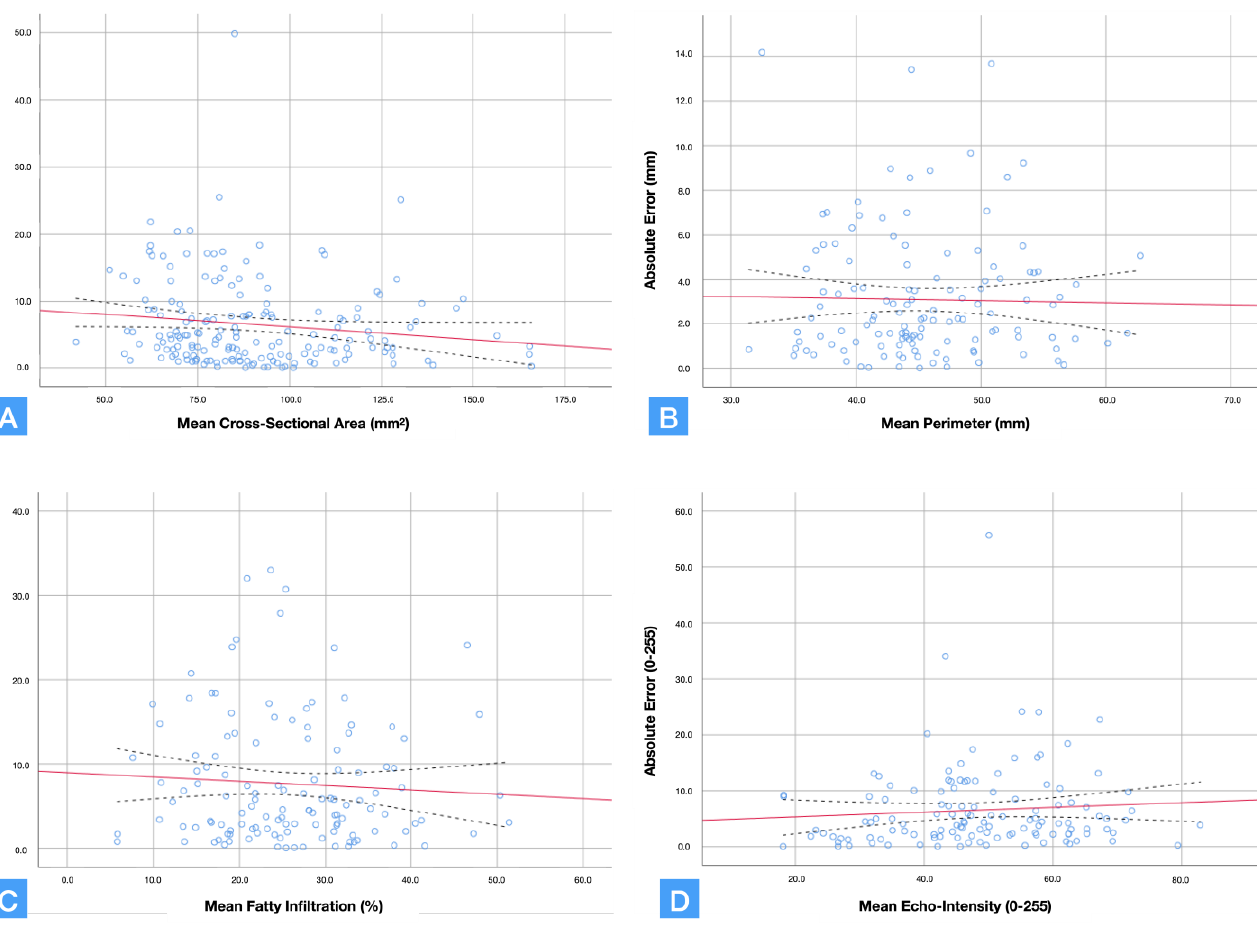
Figure 2. Bland–Altman plots assessing the relationship between mean scores obtained (X-axis) and the corresponding absolute error (Y-axis). Individual cases are represented with blue circles, the adjusted tendency line in red and 95% CI limits with black discontinuous lines for mean cross-sectional area ( A ), perimeter ( B ), fatty infiltration ( C ) echo-intensity ( D ) characteristics of cervical multifidus.